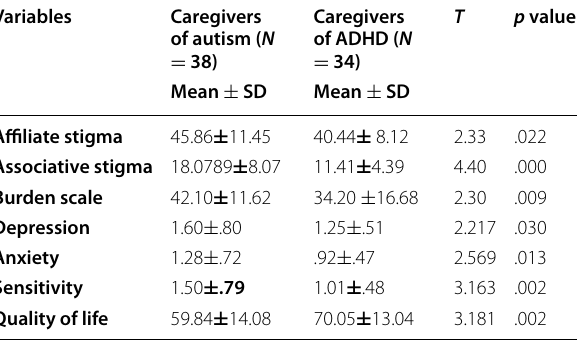
ADHD attention-deficit hyperactivity